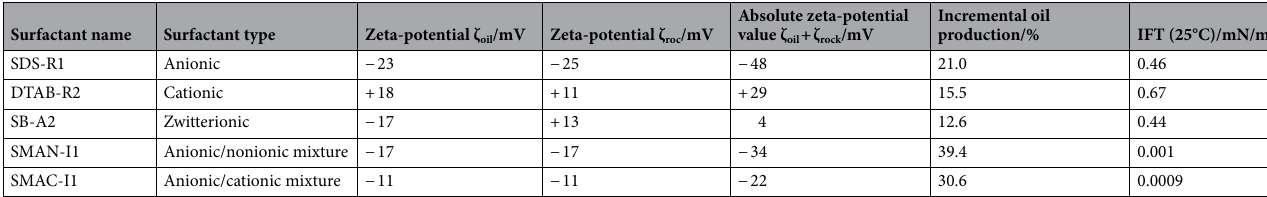
Table 1. Summary of oil production by micromodel displacement tests.